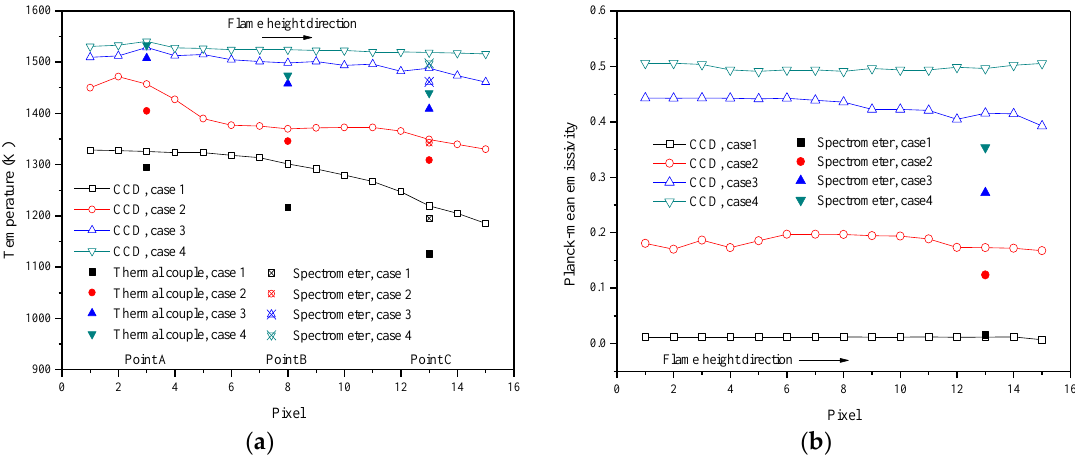
Figure 10. Measurement results by color image processing. ( a ) Flame image temperatures in the height direction; and ( b ) flame image emissivity in the height direction.